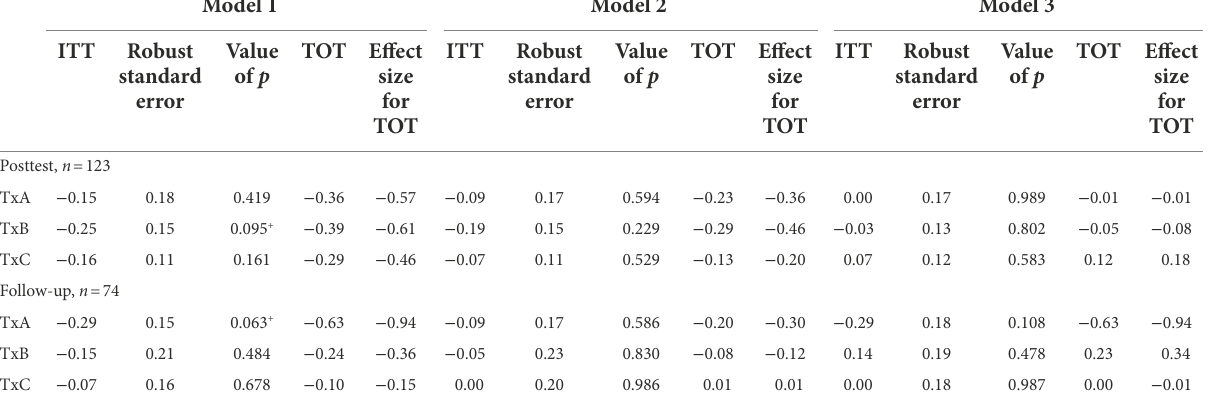
TABLE 3 Parent involvement models comparing treatment (Tx) groups to